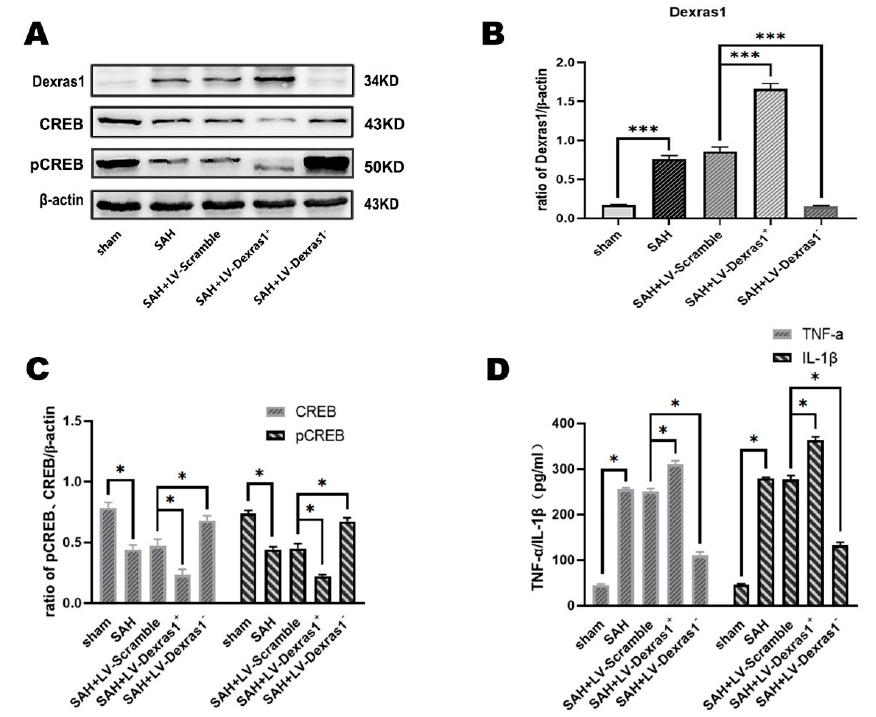
Figure 7. ( A ) Western blot detection of Dexras1, CREB, and pCREB protein expression after inter- vention with LV-Dexras1 + or LV-Dexras1 - ; ( B , C ) Western blot analysis (* p < 0.05, ** p < 0.01, *** p < 0.001); ( D ) ELISA analysis of the expression of IL − 1 β and TNF- α (* p < 0.05 ** p < 0.01).